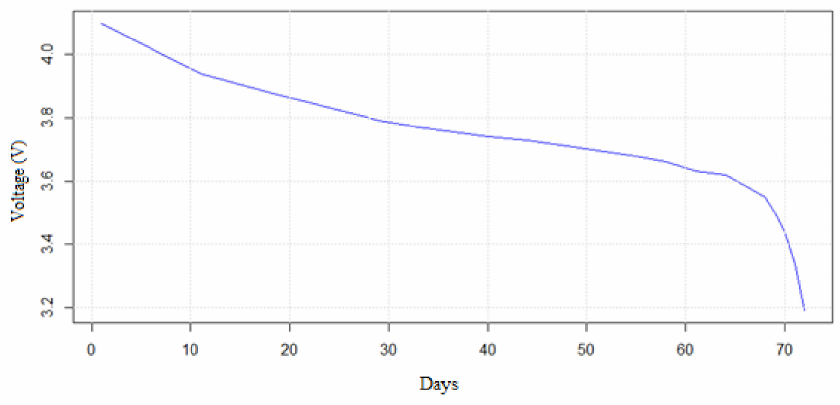
Figure 5. Node battery